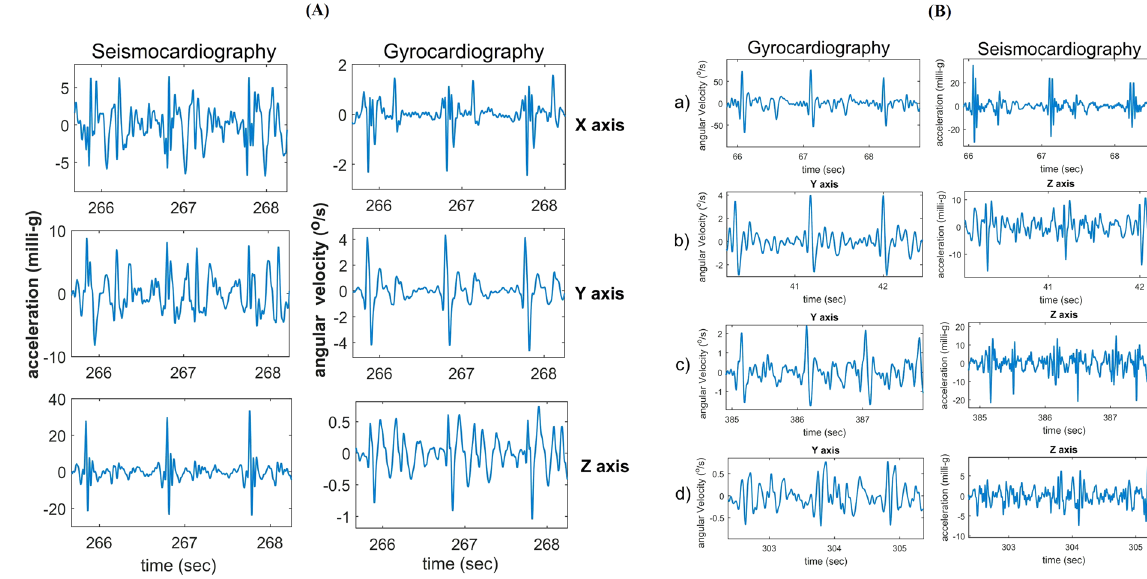
Figure 7. Visual comparison of GCG and SCG signals. Evaluation of signal quality in typical tri-axial SCG and GCG waveforms ( A ). Intersubject variability comparison for GCG against SCG ( B